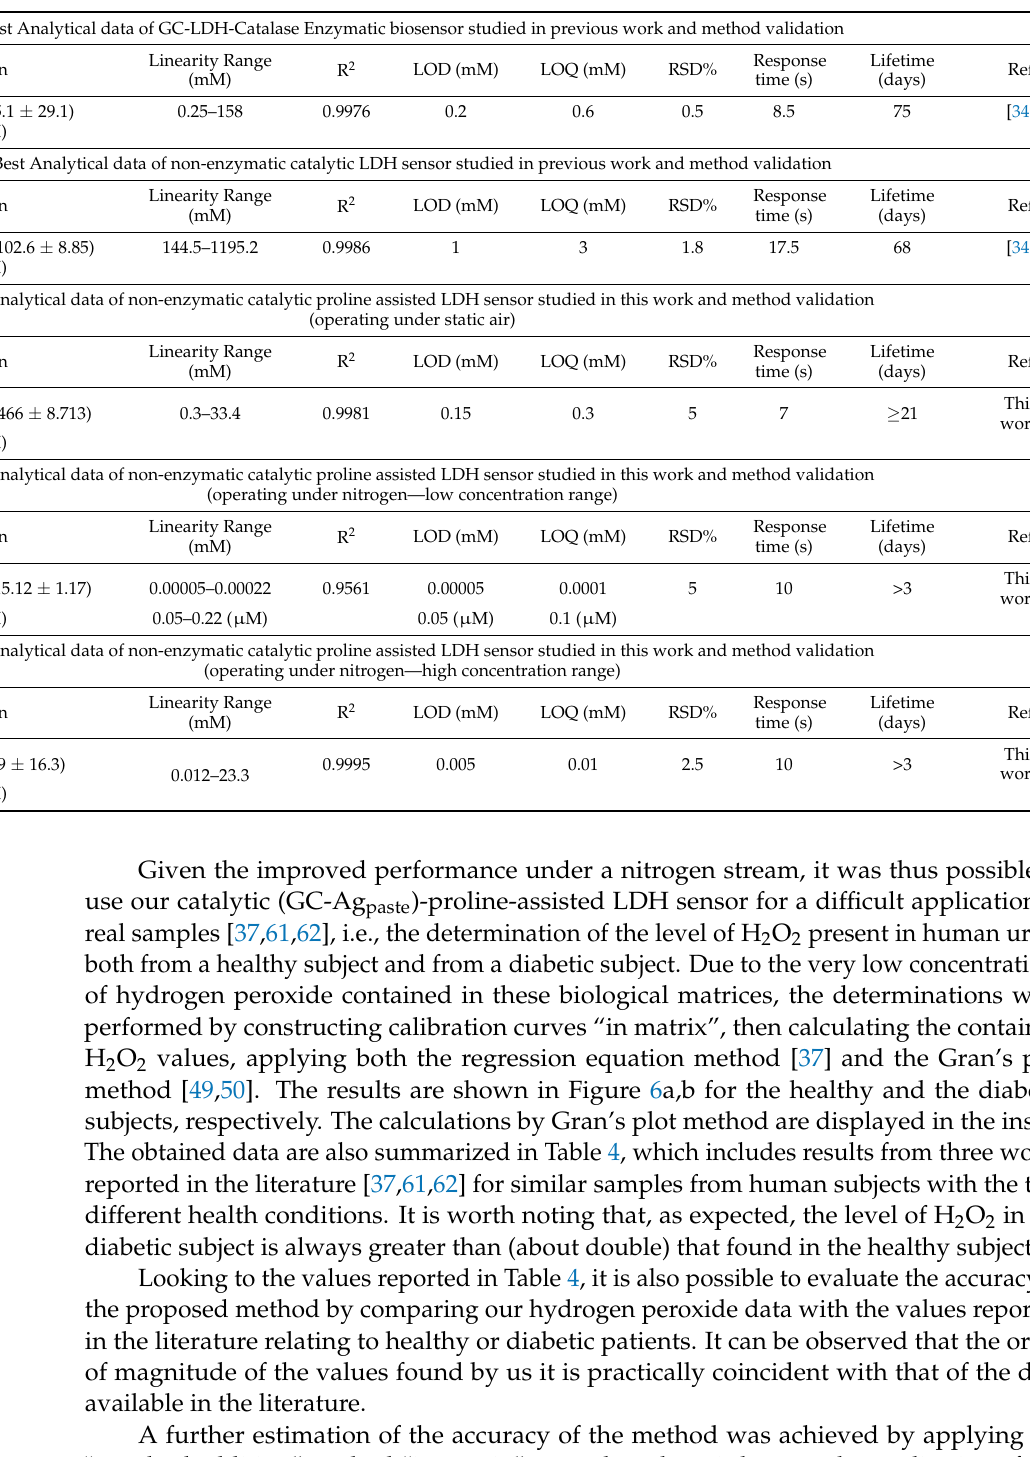
Table 3. Analytical method validation. Straight-line equations and best analytical data of the sensor studied in the present paper and in our previous study